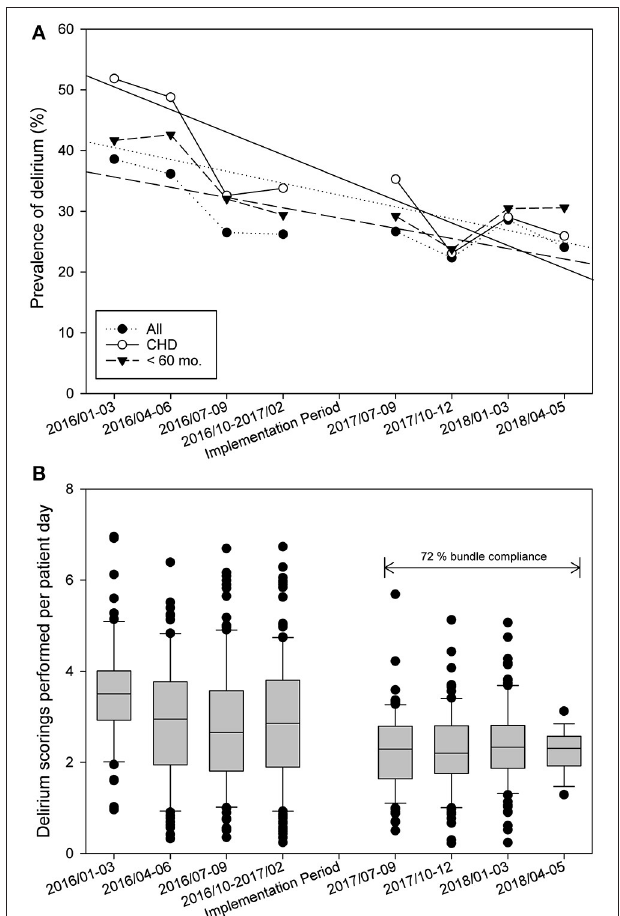
FIGURE 4 | Statistical process control chart of time [ (A) prevalence of delirium in all patients, in patients after surgery for congenital heart disease and in patients aged 60 months and younger. (B) Delirium scorings performed per